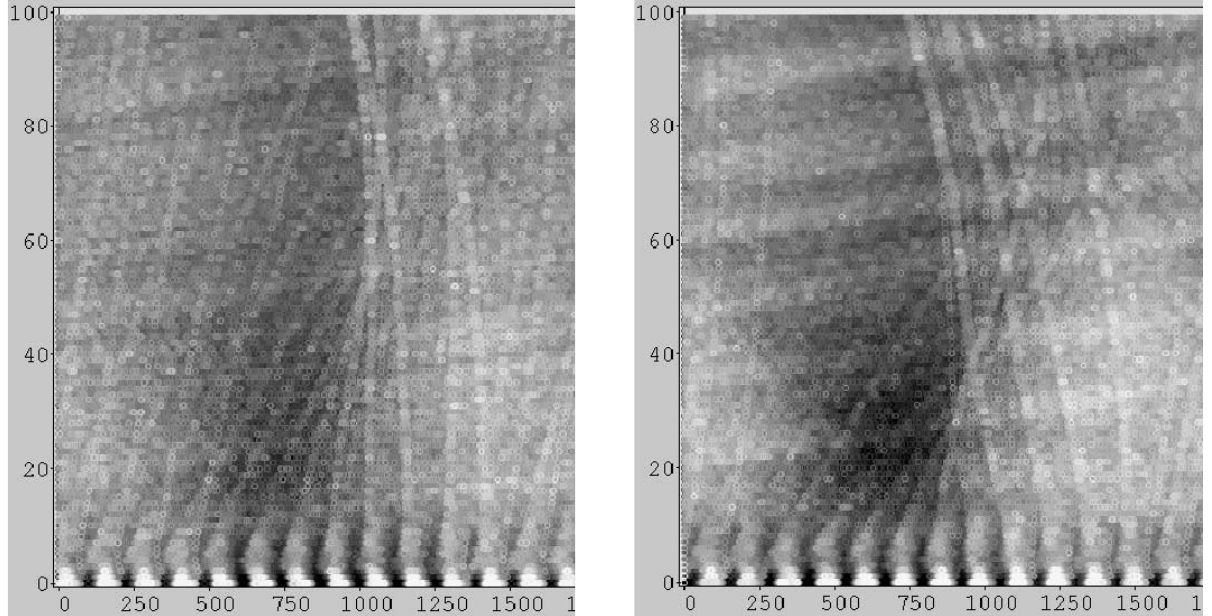
FIG. 9. Periodic holes with 6 60 keV (left) and 6 120 keV (right) energy modulation at h (cid:1) 1 . One trace each 20 turns, span 3.3 ms; abscissa in nanoseconds. 2.4 3 10 12